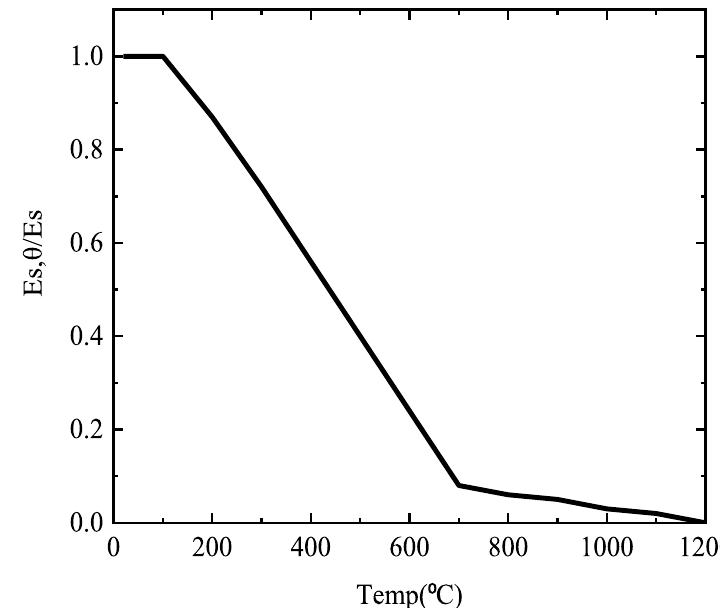
Fig. 24 Elasticity of reinforcing steel at elevated temperature [20]